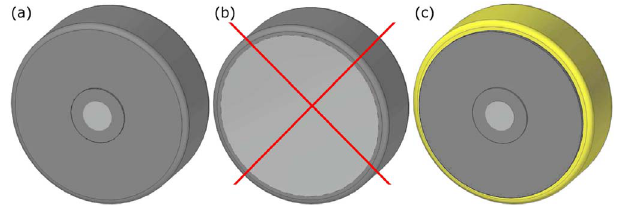
Figure 4. Three example wheels: (a) A realistic one-piece wheel with a small solid axle, (b) an unrealistic one-piece wheel with an impractically large solid axle, and (c) a realistic two-piece wheel with a soft outer wheel layer, a hard inner wheel core, and a solid axle. In the scenario of a high wheel/axle ratio, wheel (c) is being exhibited, not wheel